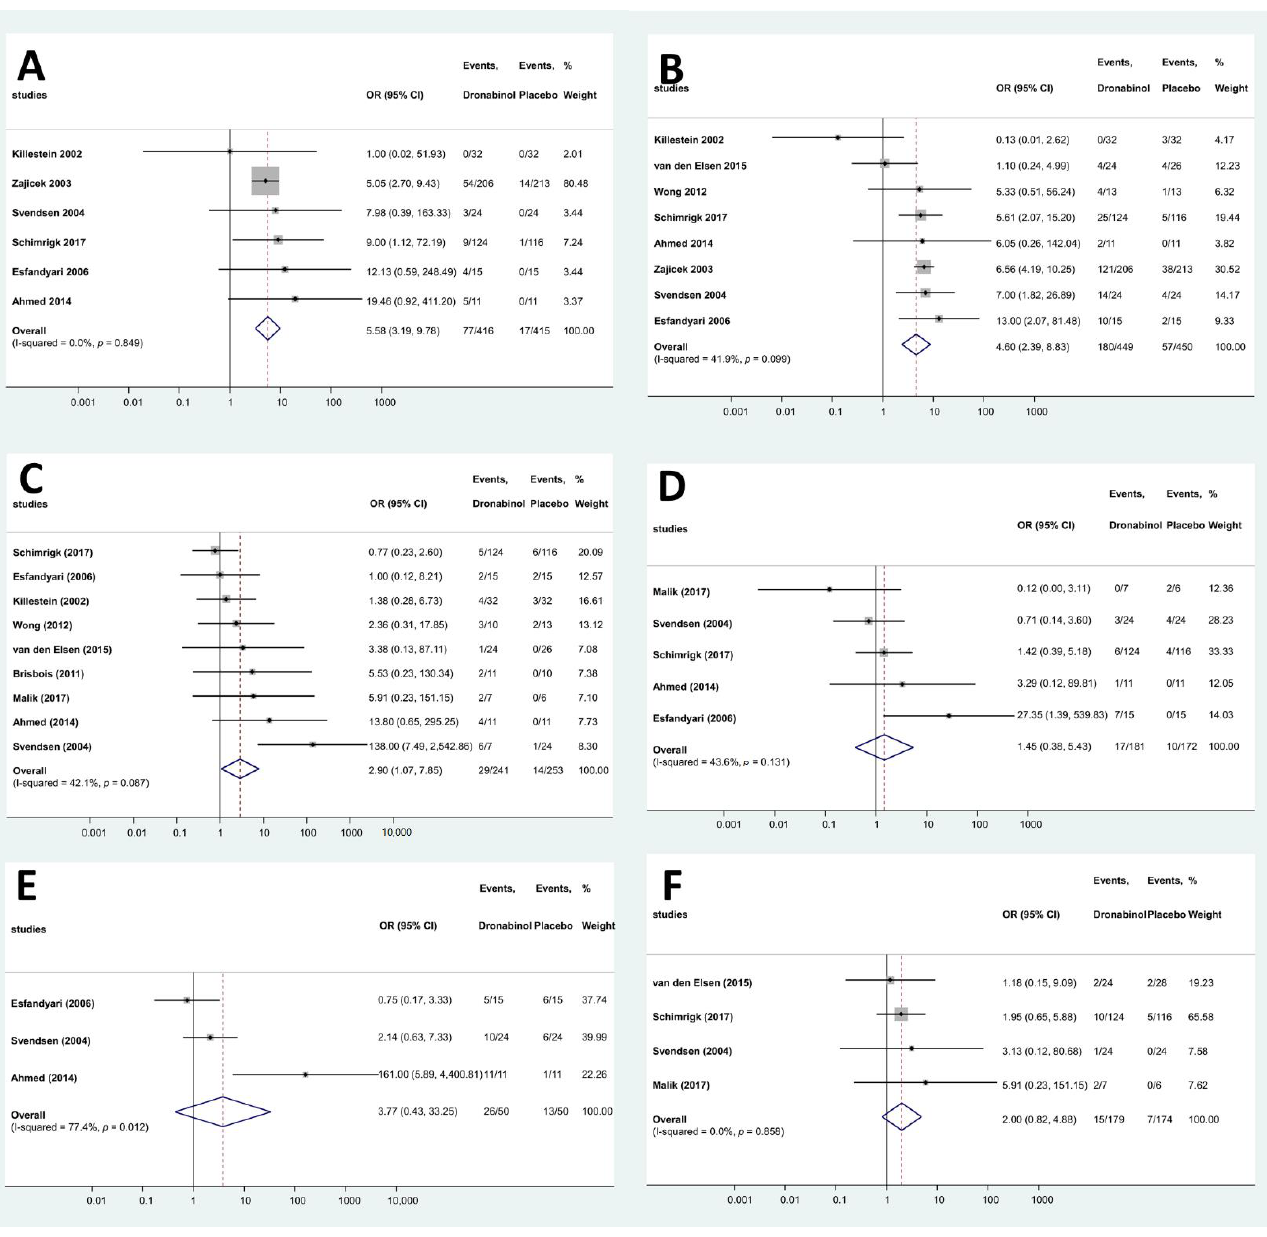
Figure 4. Forest plots of different AEs — dronabinol. (( A ): dry mouth; ( B ): dizziness; ( C ): headache; ( D ): nausea; ( E ): drowsiness; ( F ): fatigue).